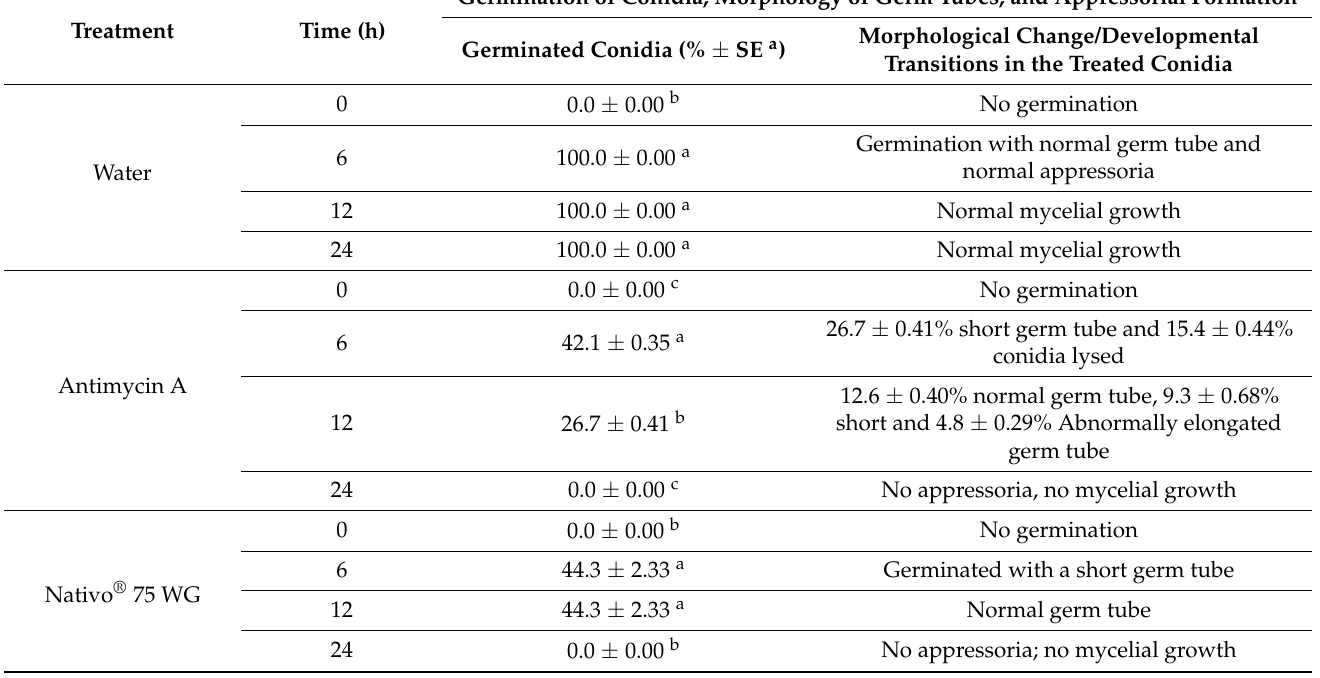
Table 1. Effects of antimycin A and the fungicide Nativo ® 75 WG on germination of conidia and morphology of germ tubes and appressoria of Magnaporthe oryzae Triticum at 10 µ g/mL in vitro.